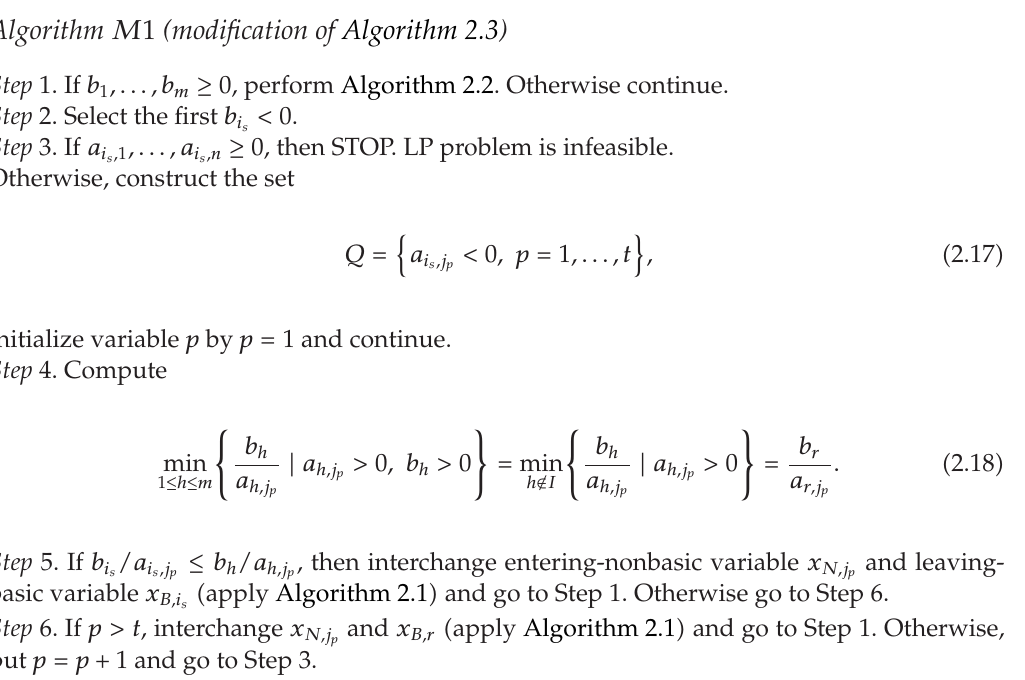
Algorithm M 1 (modification of Algorithm 2.3)